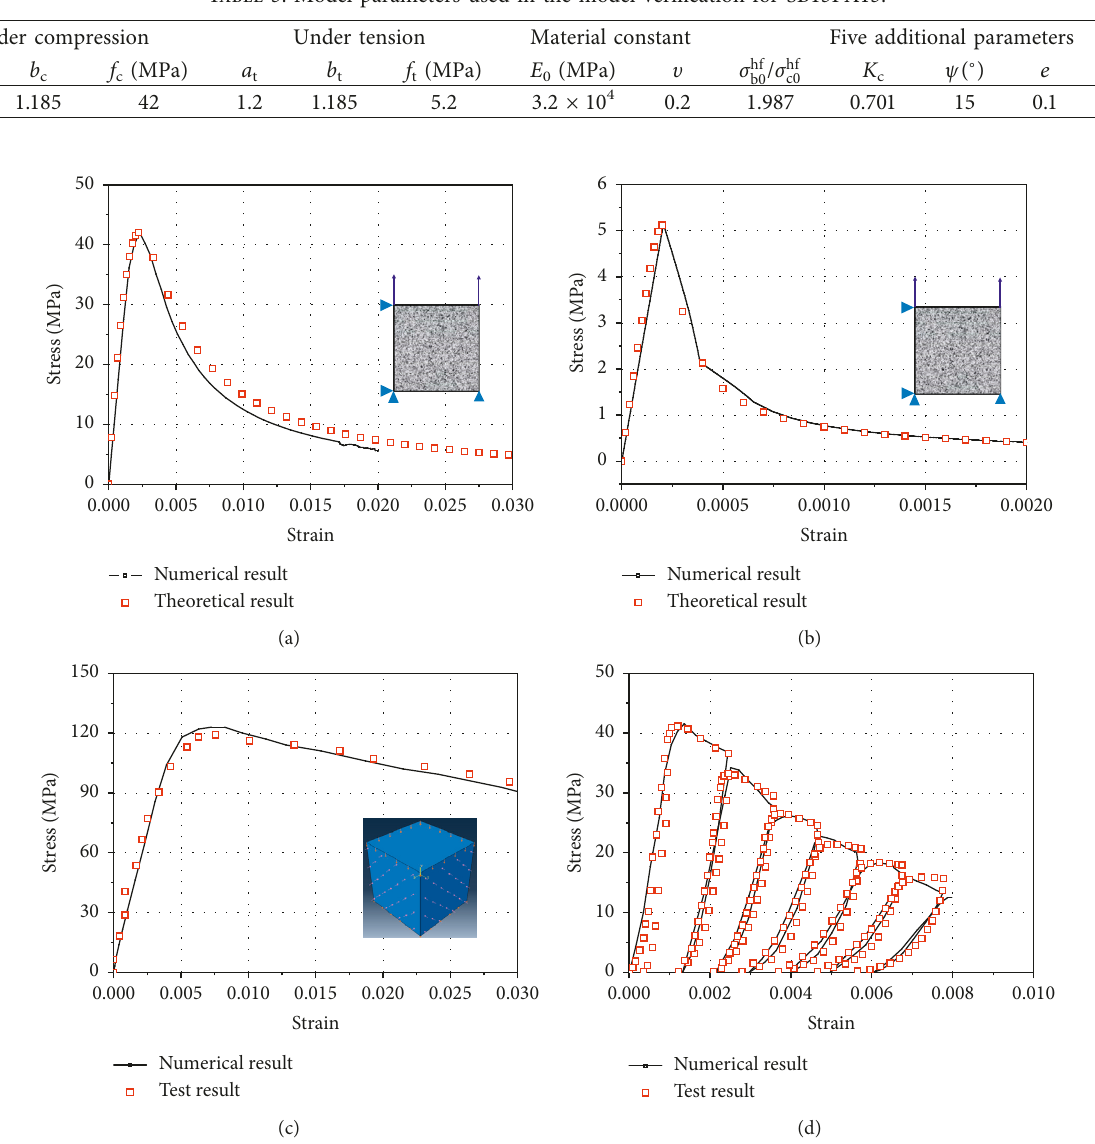
Figure 21: Material elements modeling under (a) uniaxial monotonic tension [14]; (b) uniaxial monotonic compression [15]; (c) true triaxial compression [16]; (d) uniaxial cyclic compression [58].